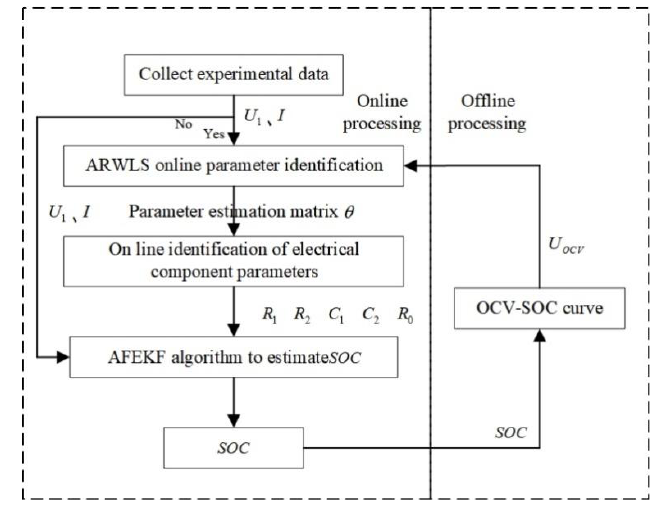
Figure 2. Fusion algorithm flowchart.